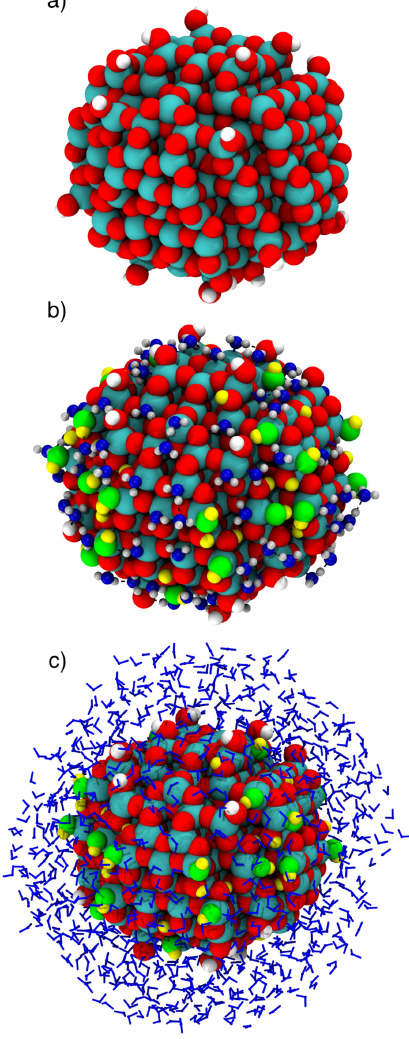
Figure 4. Optimized structure with B3LYP: ( a ) for the bare TiO 2 nanoparticle; ( b ) for the nanoparticle with an adsorbed water monolayer composed by 134 molecules ( ∼ 20% of which are dissociated); and ( c ) with QM / MM for the nanoparticle with a water multilayer of 958 molecules, using CF LJ parameters. Titanium, oxygen and hydrogen atoms of the NP are in cyan, red and white, respectively. Oxygen atoms of molecular water are in blue, while oxygen and hydrogen atoms from the dissociated water molecules are in green and yellow,